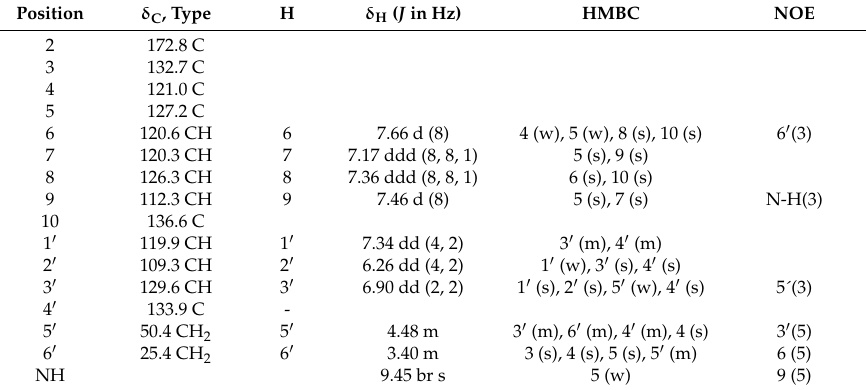
Table 3. NMR Spectral Data of Compound 9 (400 MHz for 1 H- and 100 MHz for 13 C-, CDCl 3 , δ -values in ppm, J in